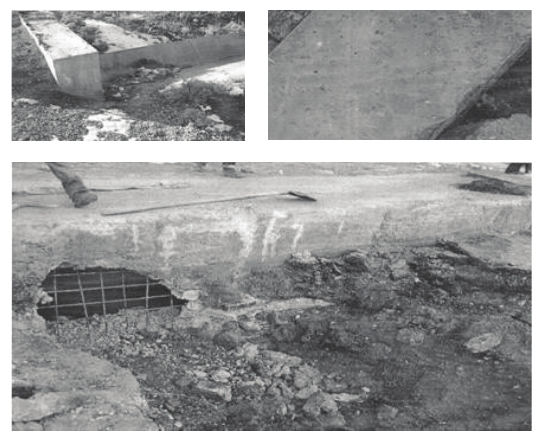
Figure 1: The deterioration of concrete examples from the locations.